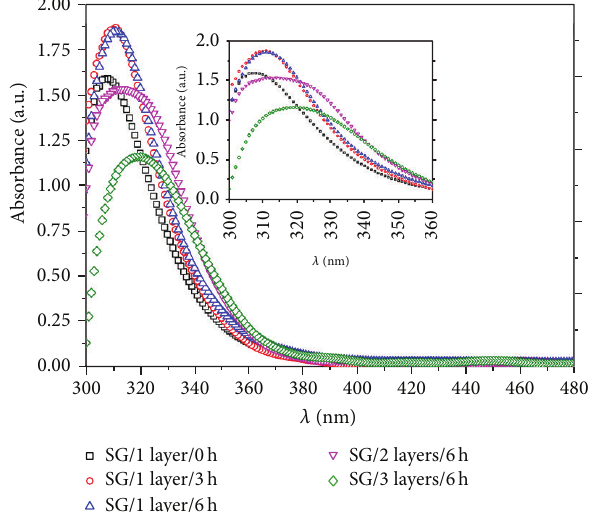
Figure 3: Absorbance (optical density) of the different sol-gel pho- toelectrodes. The slight changes in the optical properties induced by the aging time, as well as by the dip coating of multilayer photoelectrodes, are better appreciated in the